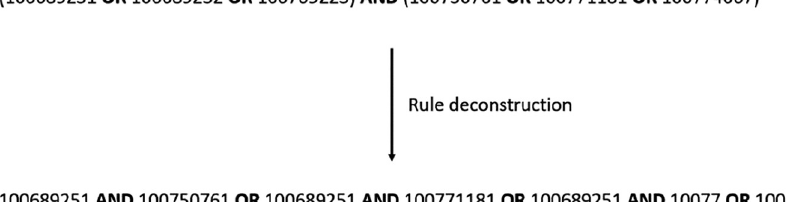
Figure 2: Decomposition of the GPR association assigned to the PI45P3K_cho reaction in BiGG models